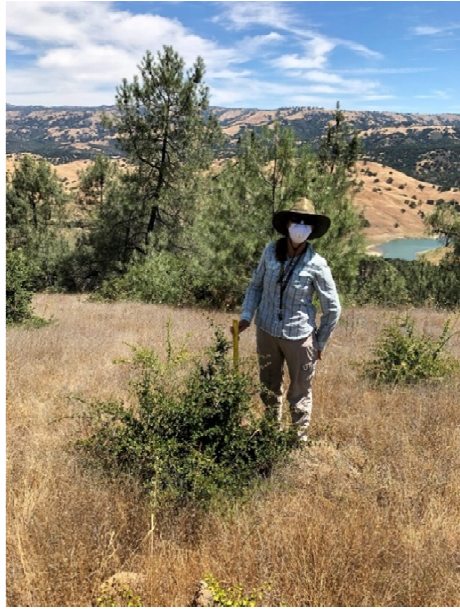
Figure 6. Healthy Coyote ceanothus growing after successful Phytophthora eradication at a mitigation site in Santa Clara County. Credit: Janell Hillman, Santa Clara Valley Water District.